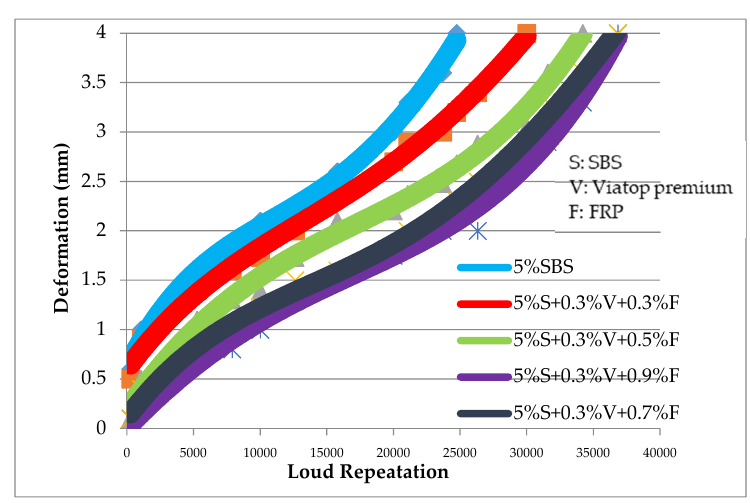
Figure 14. Results of Fatigue test.